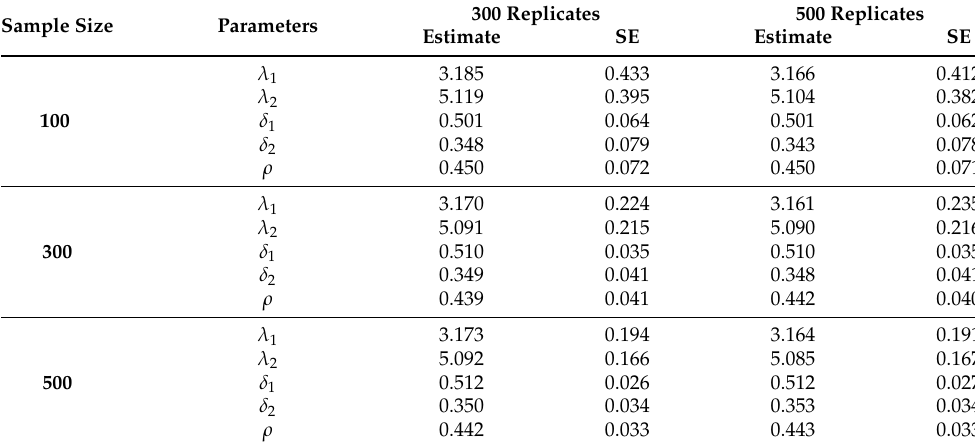
Table 2. Parameter estimates using the Gaussian copula for a univariate and joint distribution for 300 and 500 replicates.